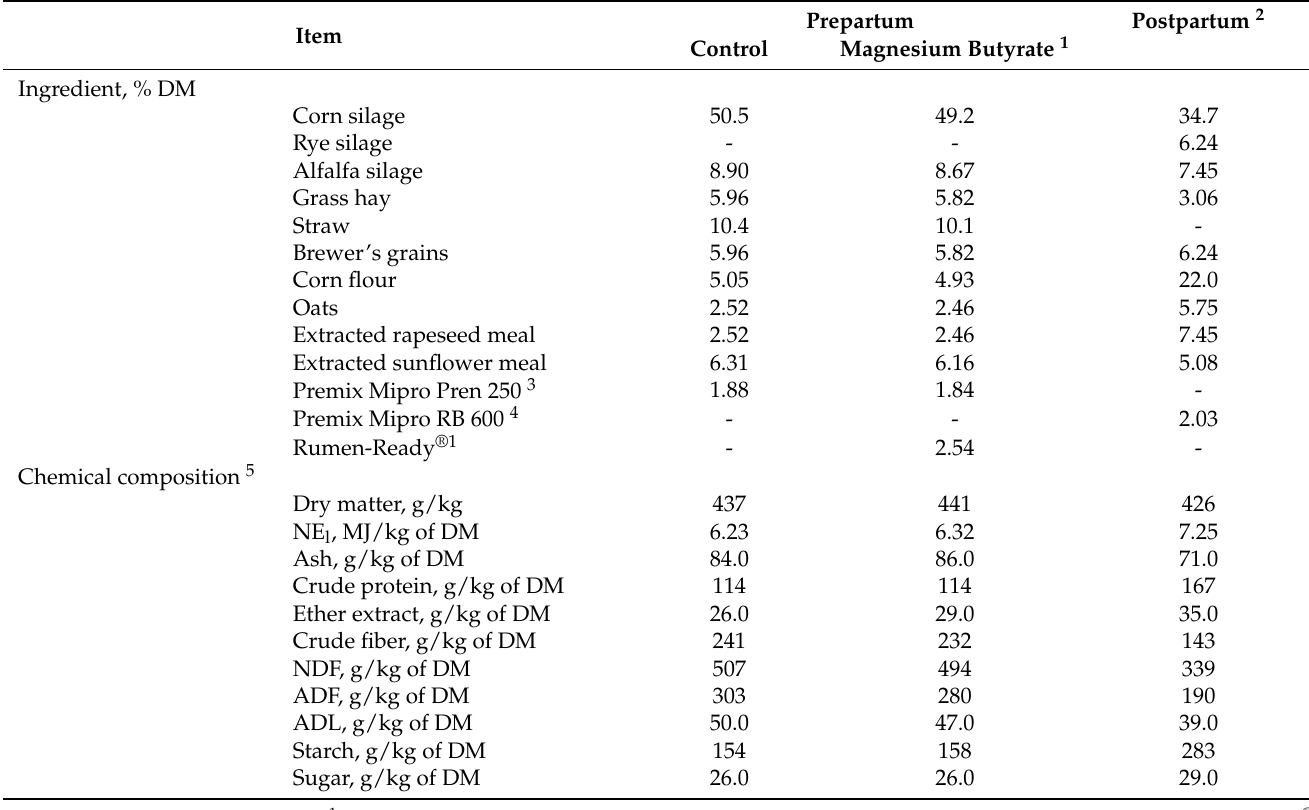
Table 1. Ingredient and chemical composition of prepartum and postpartum total mixed rations for the Control and Magnesium butyrate